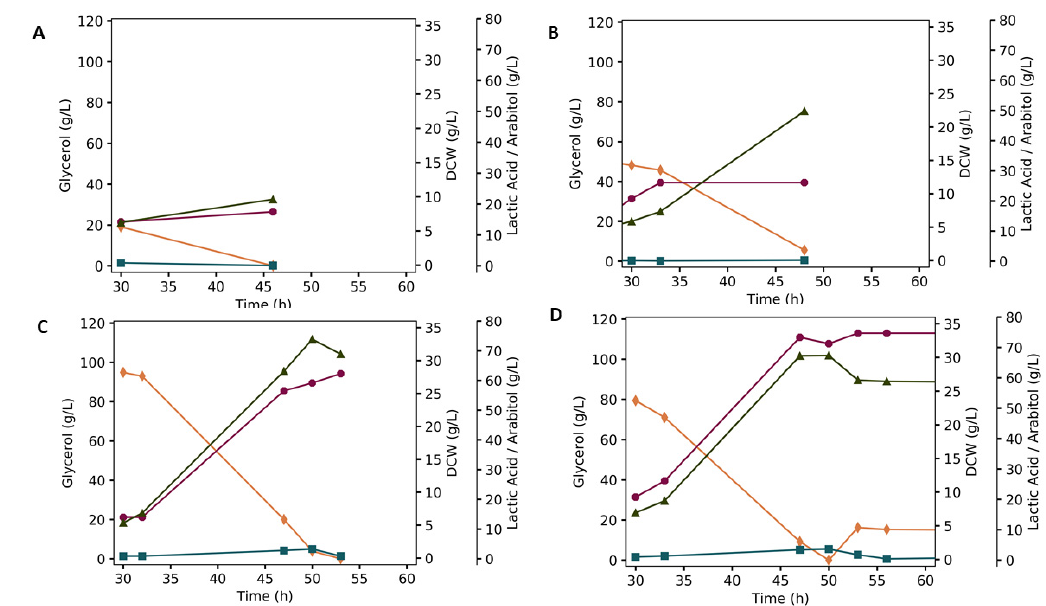
Figure 4. Fermentation profile for the GLp strain fed with different initial concentrations of glycerol in the restricted aerobic phase: 2% ( A ), 6% ( B ), or 8% ( C ). ( D ) GLpard strain, fed in the restricted aerobic strain with glycerol at 8%. Plotted are glycerol consumption (orange diamond), arabitol production (blue square), lactate production (green triangle) and dry cell weight (DCW) (purple circle). The experiments were carried out in biological duplicates, and the figure shows a representative fermentation